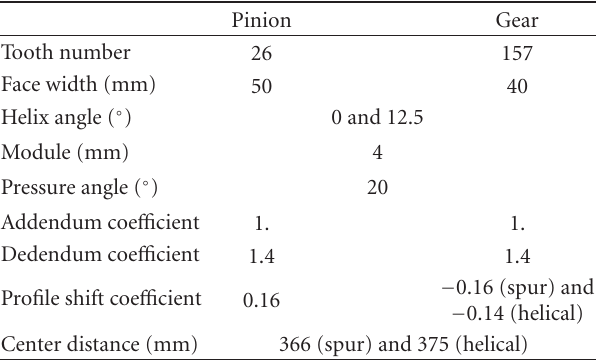
Table 1: Gear data.